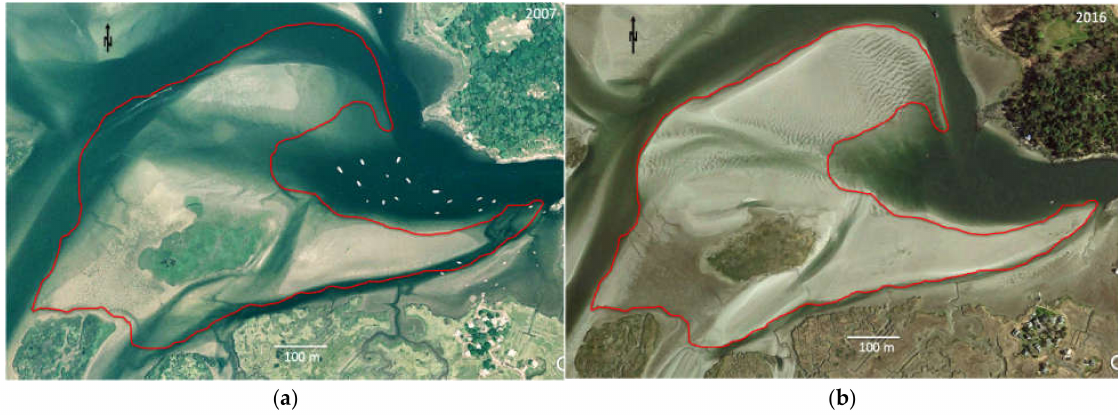
Figure 14. Morphology of the inner flood-tidal delta (outlined in red) in ( a ) 2007 (U.S. Geological Survey) and ( b ) 2016 (Landsat Copernicus). During this interval, the delta volume increased by approximately 185,000 m 3